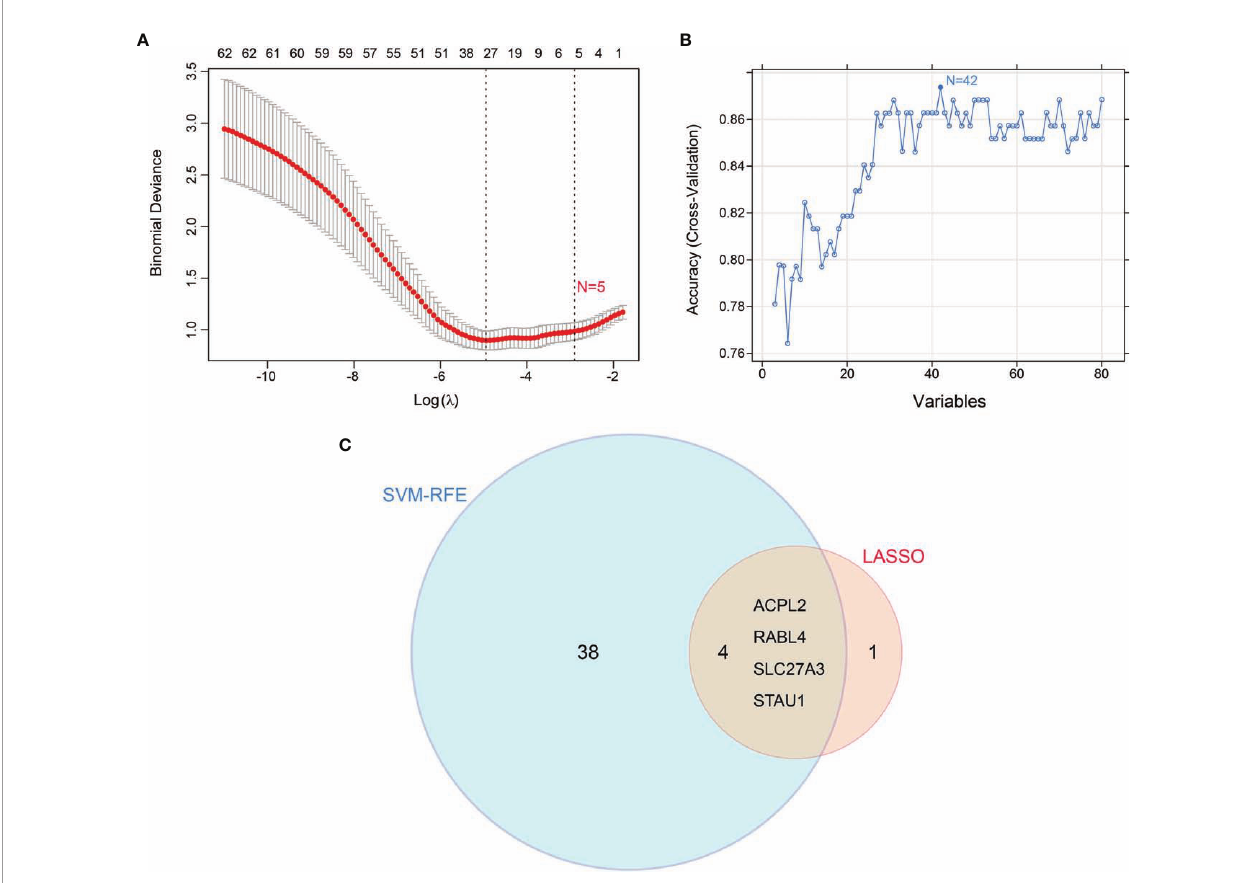
FIGURE 3 | Screening candidate diagnostic markers for chronic obstructive pulmonary disease . (A) Diagnostic markers were screened by the least absolute shrinkage and selection operator (LASSO) logistic regression algorithm. (B) Diagnostic markers were screened by a support vector machine-recursive feature elimination (SVM-RFE) algorithm. (C) Venn diagram of variables screened by LASSO and SVM-RFE